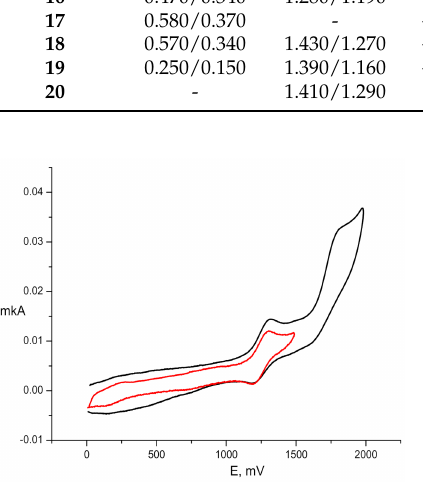
Figure 4. The cyclic voltammogram of complex 16 in the anodic range (sweep rate 100 mV/s,